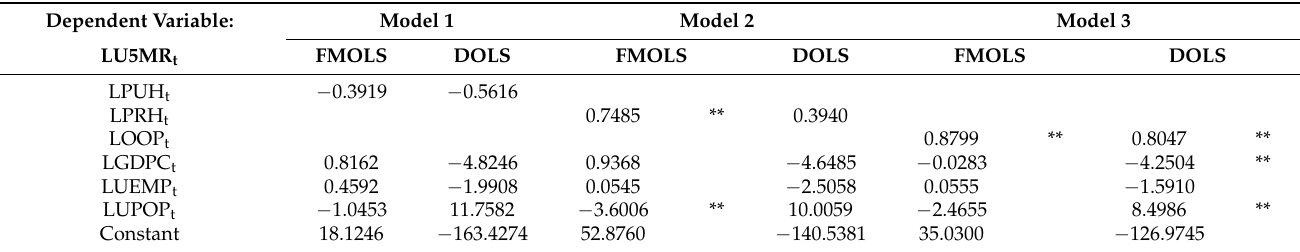
Table 5. Long-run estimates based on FMOLS and DOLS method.